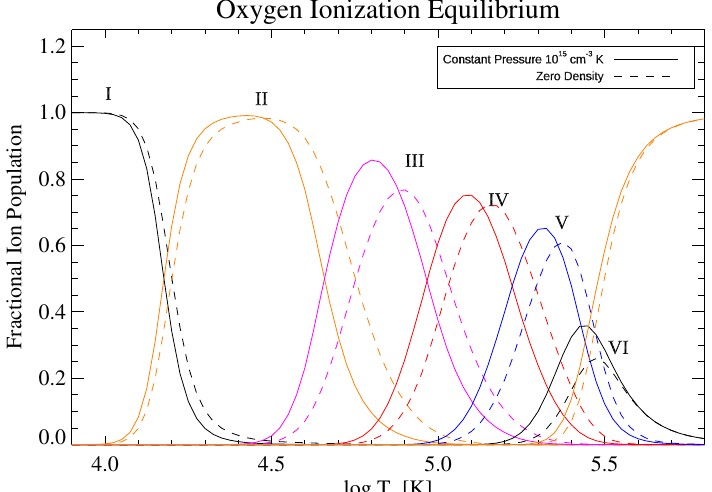
Figure 2. Relative ion populations for oxygen, assuming ionization equilibrium. The full lines indicate the values with all the density-dependent effects included (for a constant pressure), while the dashed lines show the zero density